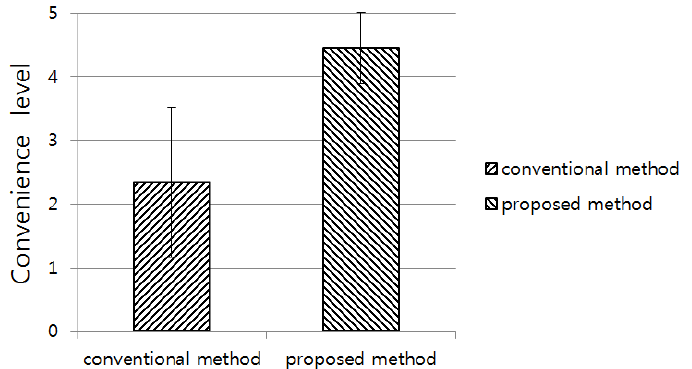
Figure 14. Comparison of convenience level between the conventional and proposed